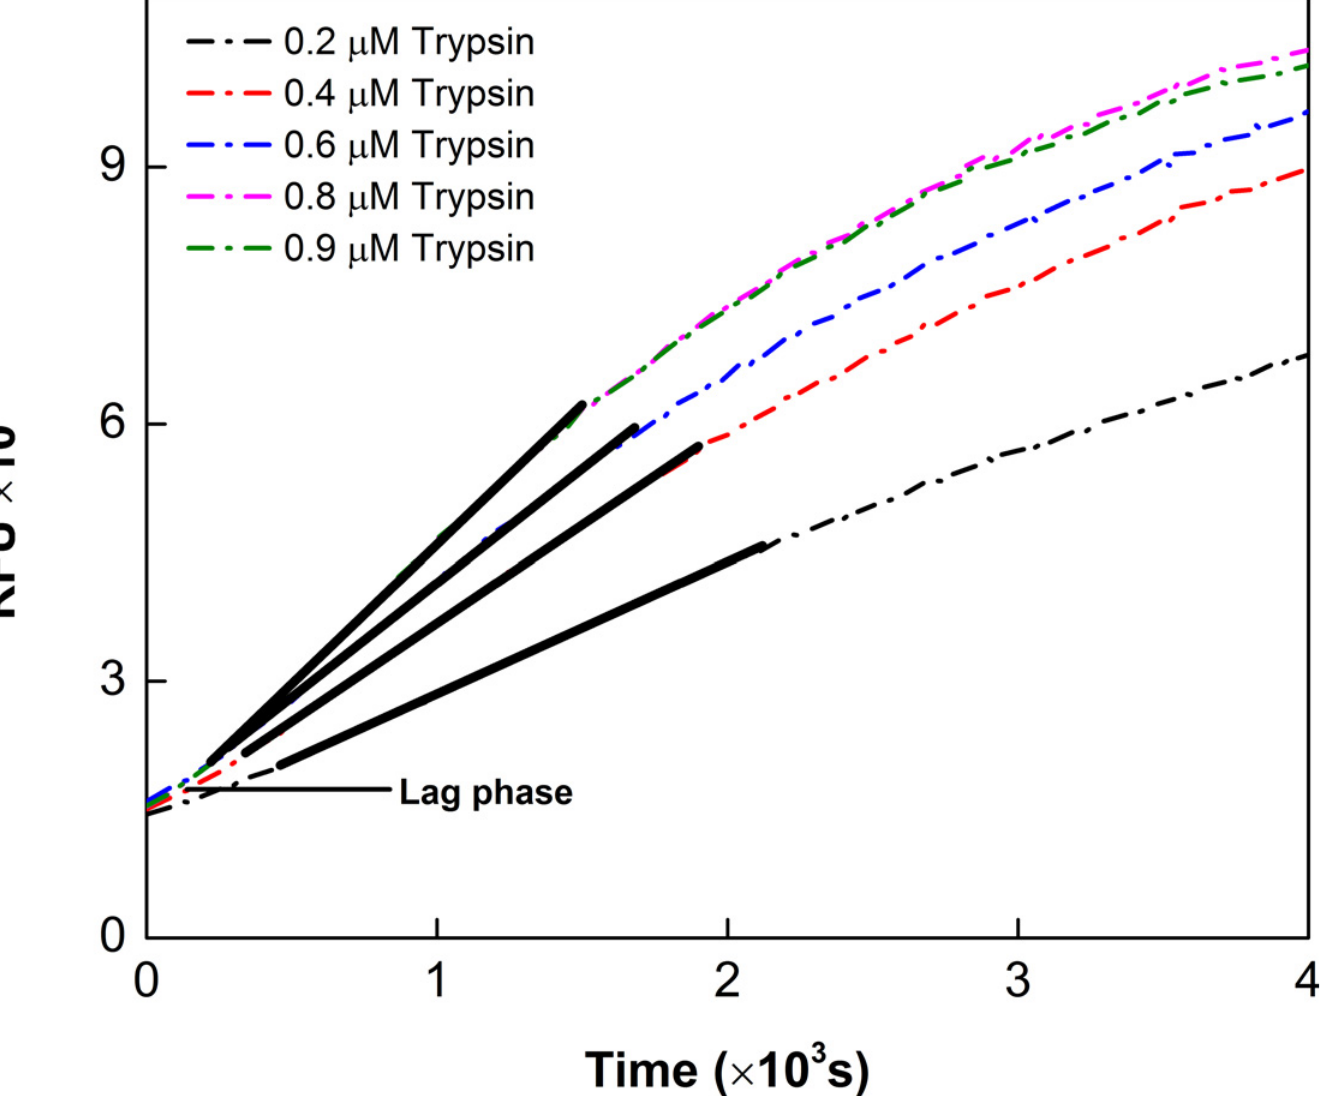
Fig 5. Real-time Progress Curve for SIRT5-catalyzed Desuccinylation Reaction. The time courses of the SIRT5 catalyzed reaction using the fixed concentrations of Ac-Suclys-AMC substrate and NAD + , and varying concentrations of trypsin as the coupling enzyme are shown. The dashed curves represent the time dependent increase in fluorescence at 460 nm ( λ ex = 350 nm) due to release of 7-hydroxyl-4-methylcoumarin (AMC) from the substrate. The solid lines indicate the linear regression analysis of the data after the initial lag phases (the dashed